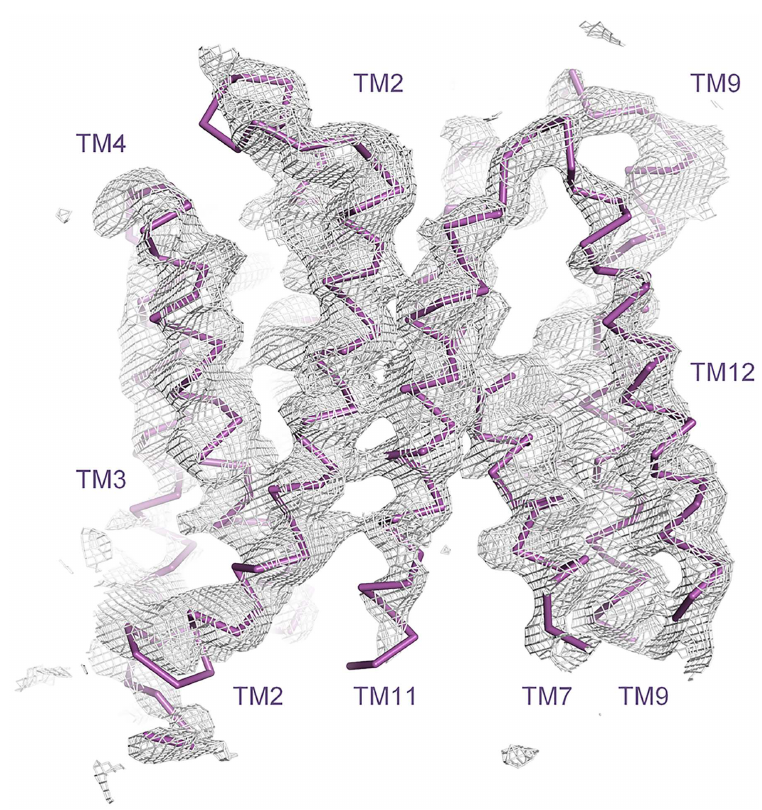
Fig 3. Experimental electron density map. The structure is shown in magenta, and the density modified MIRAS phasedelectron density map is shown at 1 σ as a grey wire mesh.